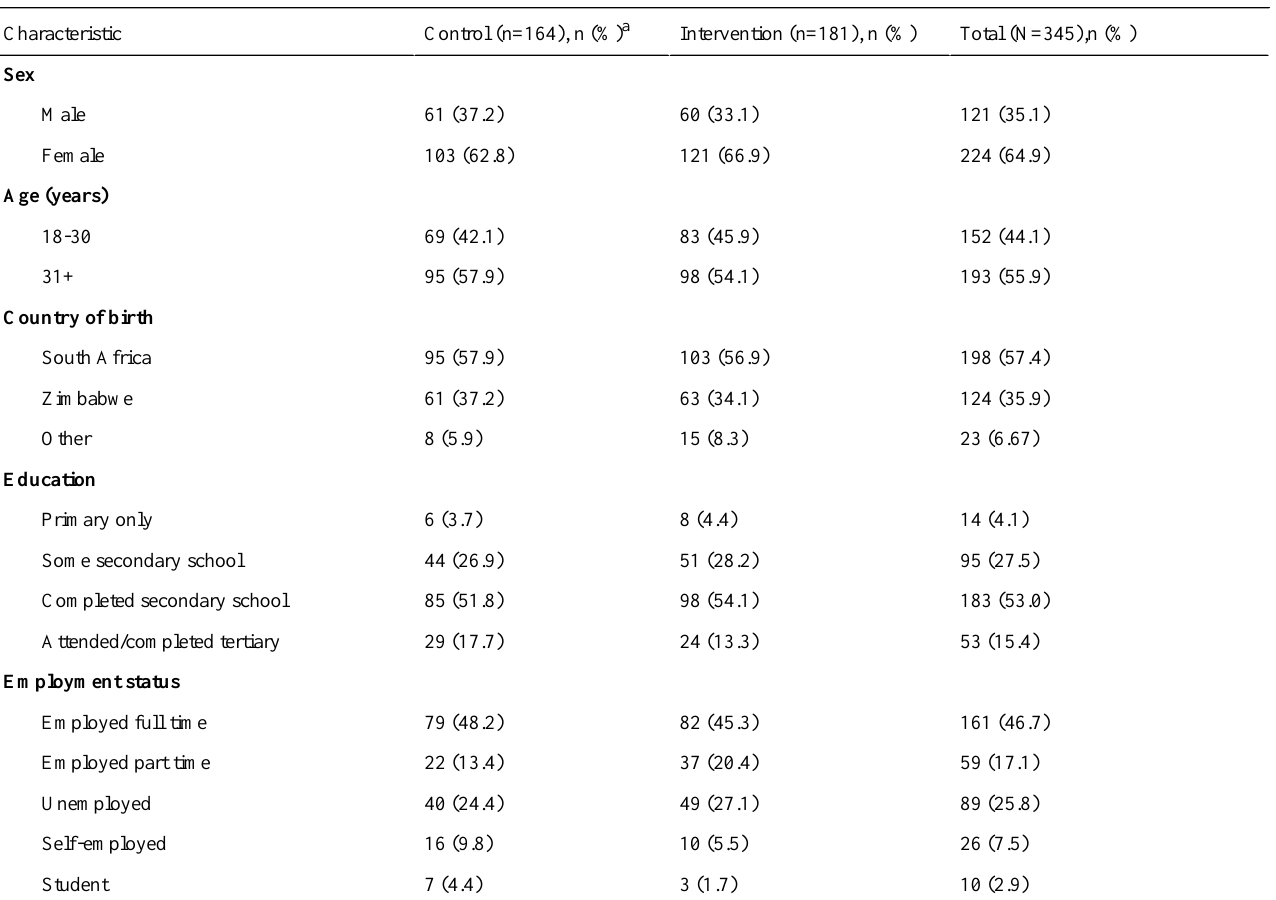
Table 1. Baseline characteristics of SmartLink trial